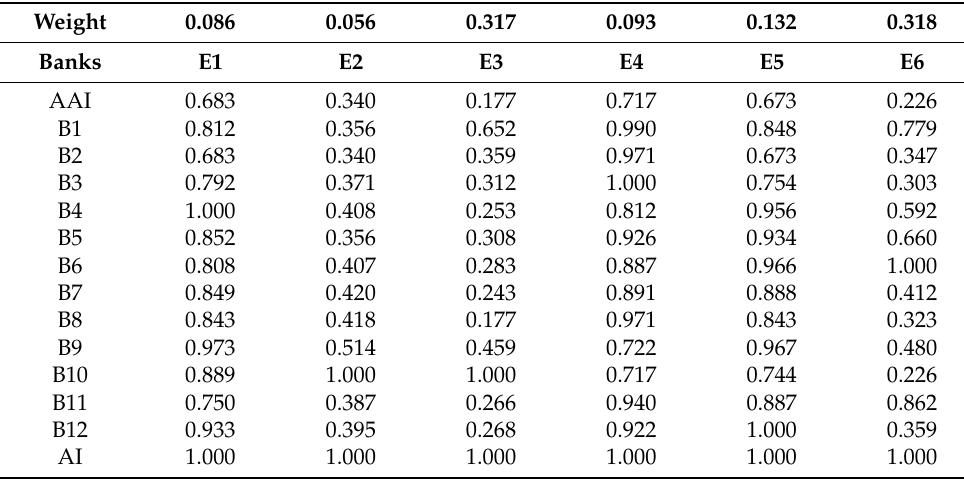
Table 13. The normalized decision matrix of bank efficiency for pre-COVID-19. Weight